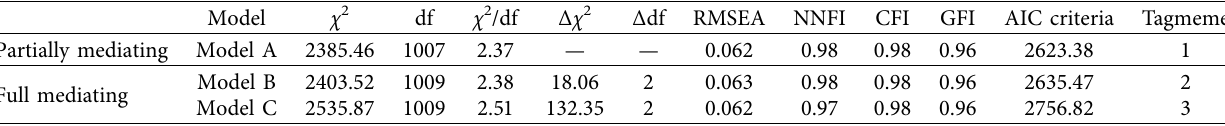
Table 2: Three models’ fitting indices and their